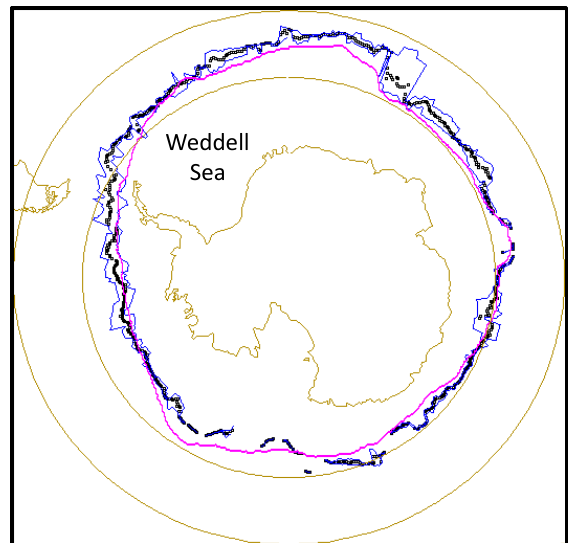
Fig. 2. Sample image of the Arctic ice edge north of Russia near Franz Josef Land (centered at 78 ◦ N and 54 ◦ E) on 4 September 1964. The estimated boundary between the ice and ocean is marked by red “#” marks; two openings (leads) within the ice are marked by blue “#” near the ice edge at the top of the image.